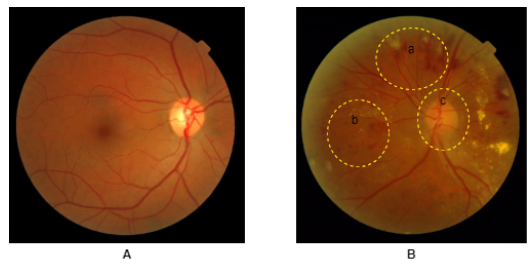
Figure 1. (A) Normal retinal image and (B)retinal image with diabetic eye disease; (a) blood vessel rupture; (b)